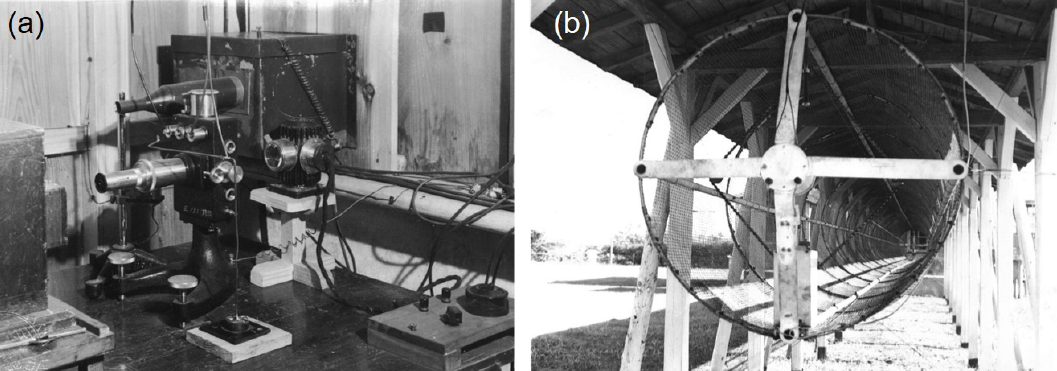
Figure 13. (a) A space charge meter and (b) a collector part of the air conductivity observation system (photo supplied by Kakioka Magnetic